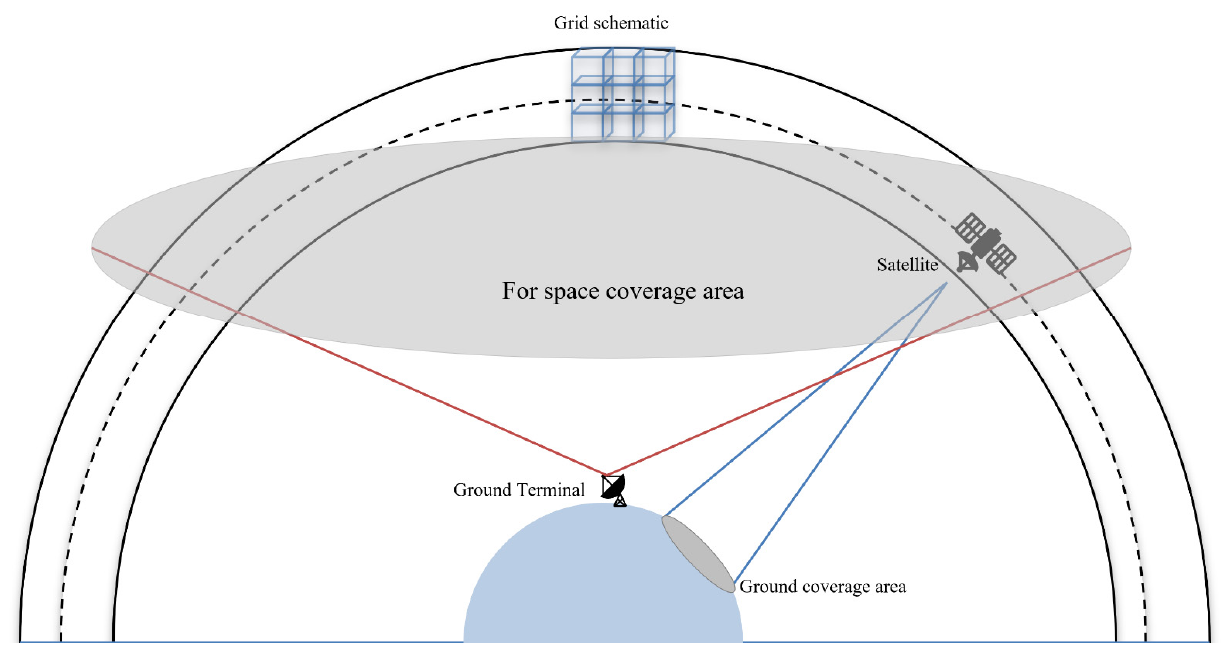
Figure 3. Grid-based modeling of satellite trajectories.